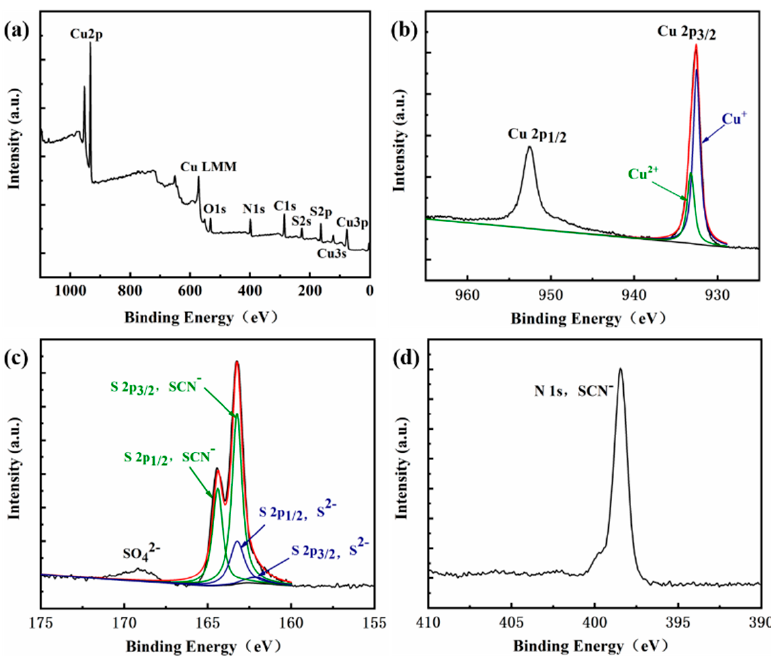
Figure 10. XPS spectra of copper products: ( a ) survey; ( b ) copper; ( c ) sulfur; ( d ) nitrogen.